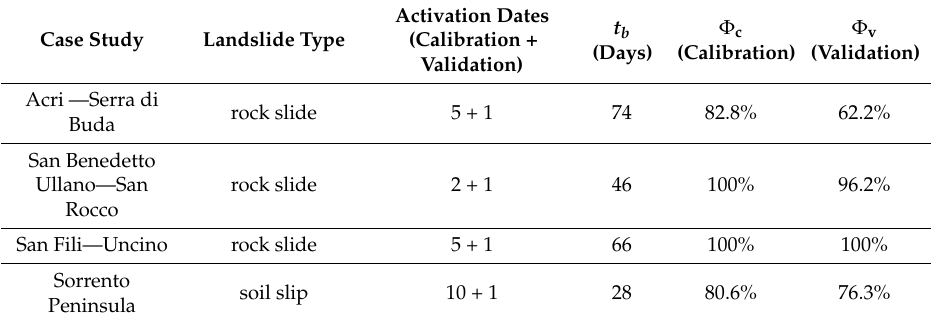
Table 4. Model results for the considered case studies. For each case, the following details are listed: landslide type; number of activation dates employed for calibration and validation; base time of the optimal kernel; maximum fitness obtained in calibration and in